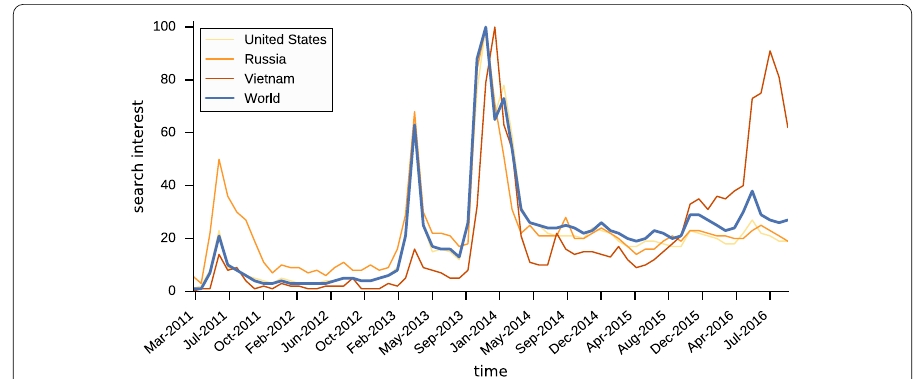
Figure 3 Google Trends time series about Bitcoin, for selected countries